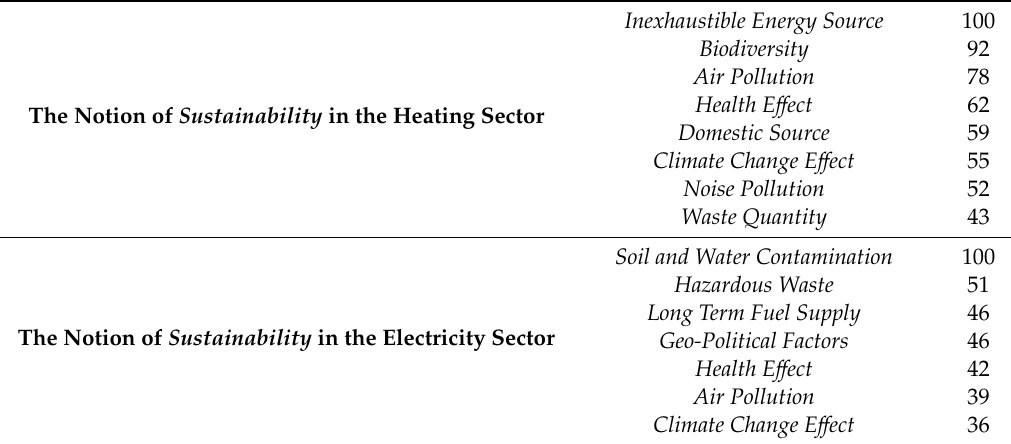
Table 5. Ranking of sub-criteria assigned to the main criteria on a scale of 0–100, until threshold K i